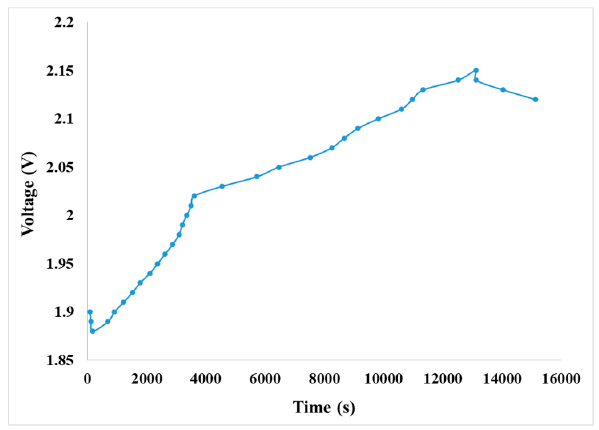
Figure 13. 1 A constant current charging curve.